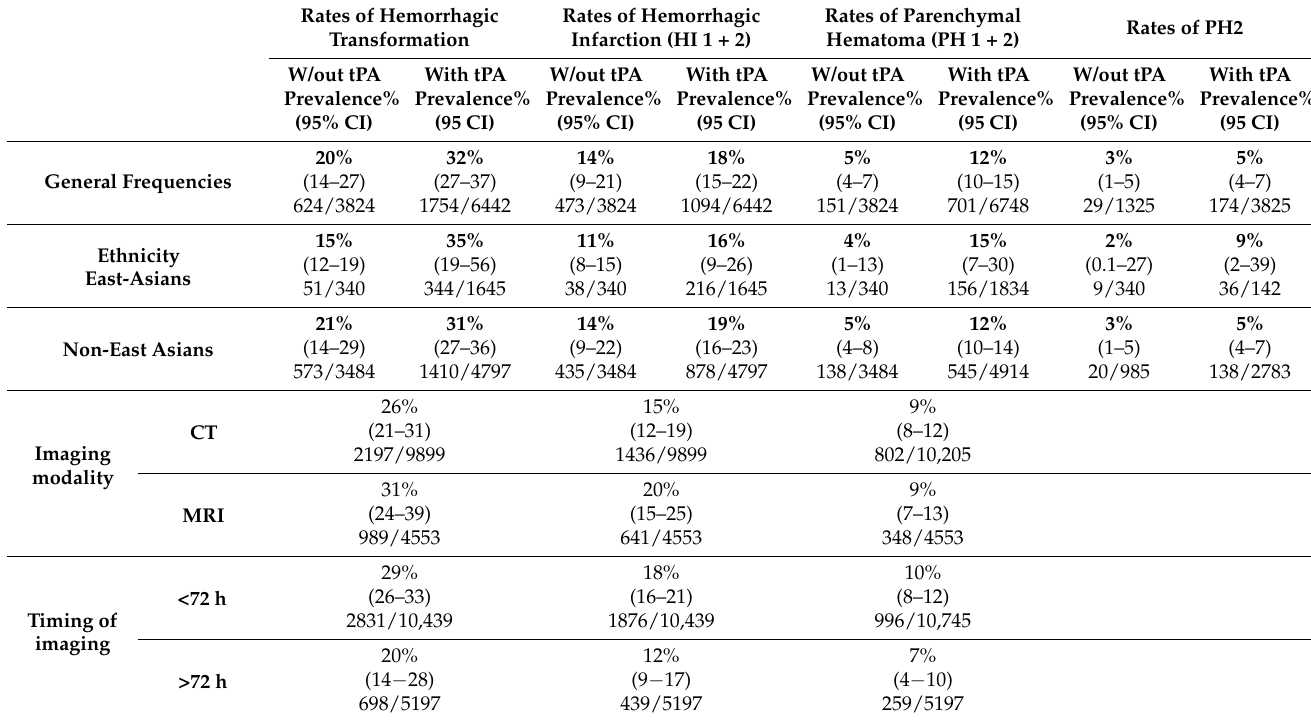
Table 1. Prevalence (%) of hemorrhagic transformation.